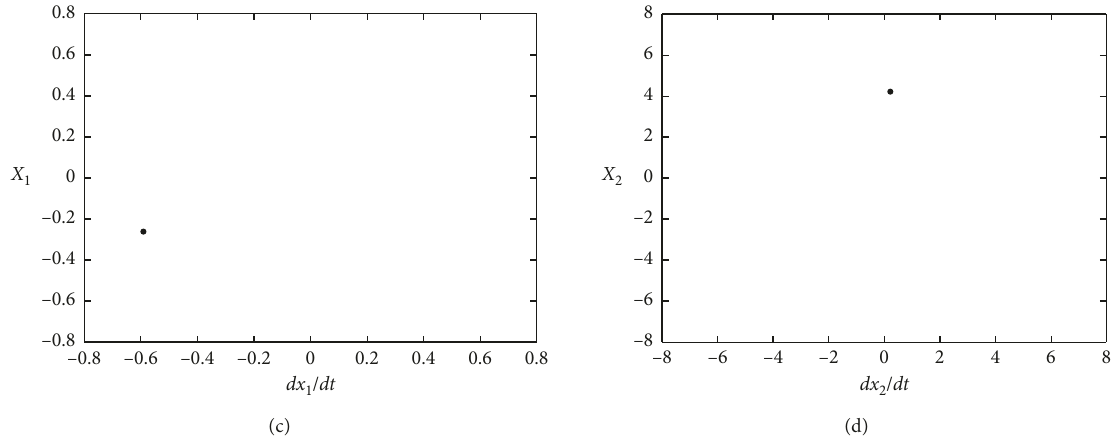
Figure 3: Vibration characteristics of hull dynamic system for ω diagram in x 2 direction. (c) Poincar´e map in x 1 direction. (d) Poincar´e map in x 2 direction.